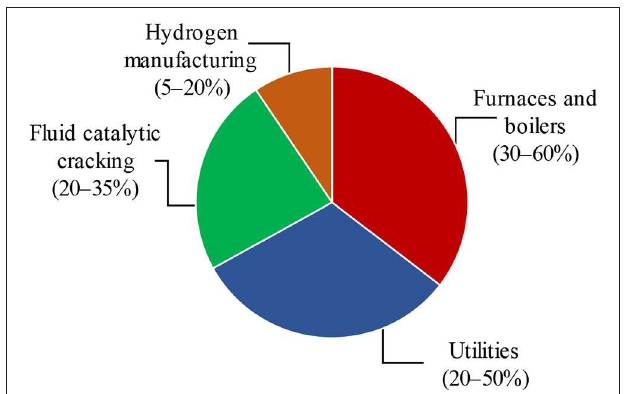
FIGURE 1 | Overview of major CO 2 emissions sources from refineries, adapted from Straelen et al. (2010) with permission from